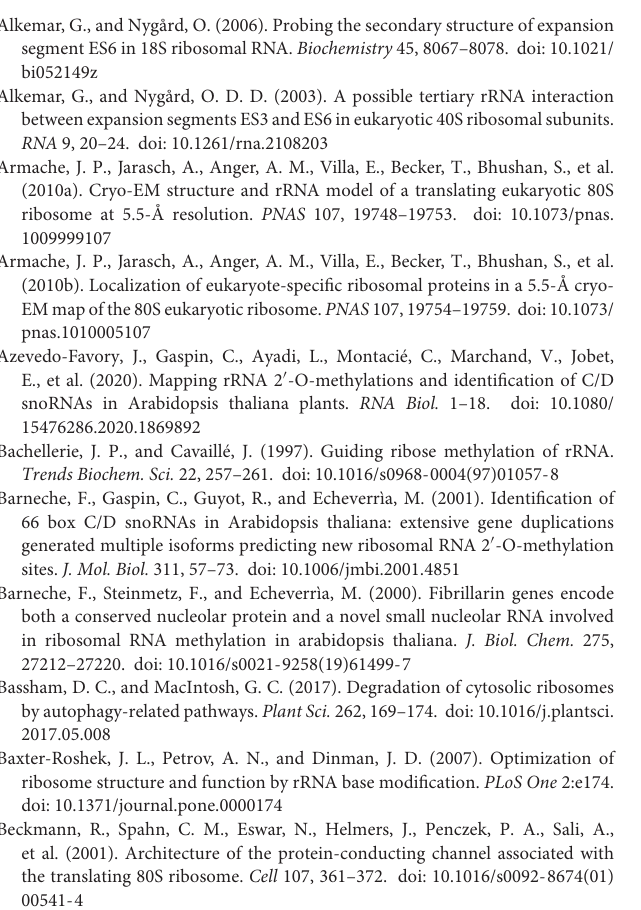
sites. Not determined